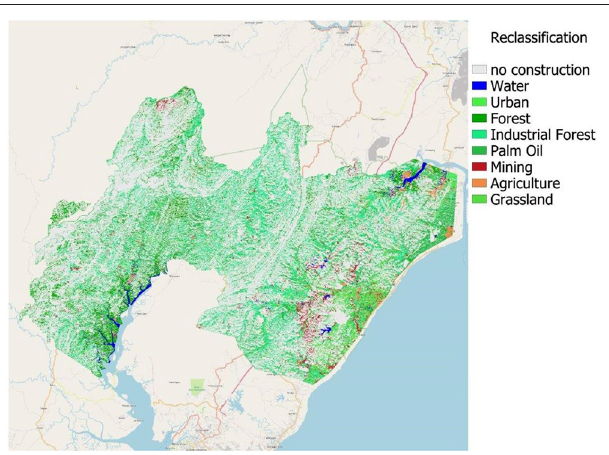
FIGURE 13 | Solar energy potential with dual land